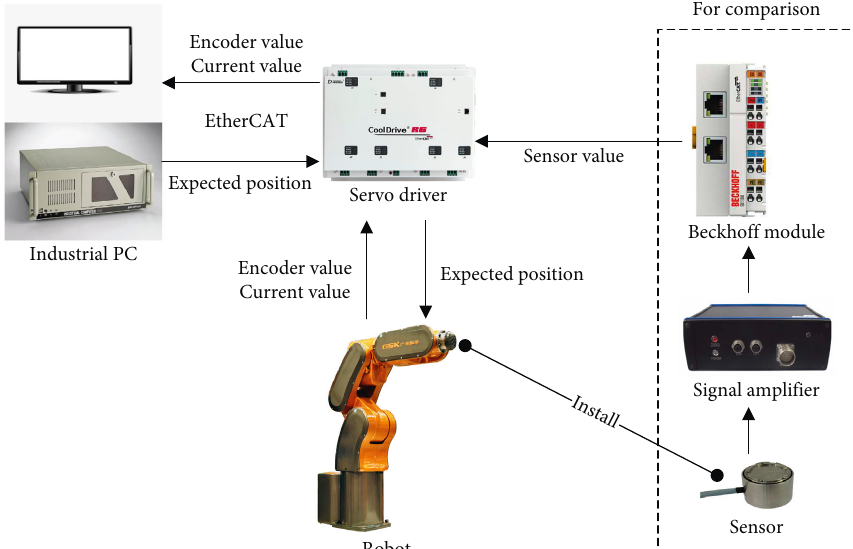
Figure 1: Hardware framework.